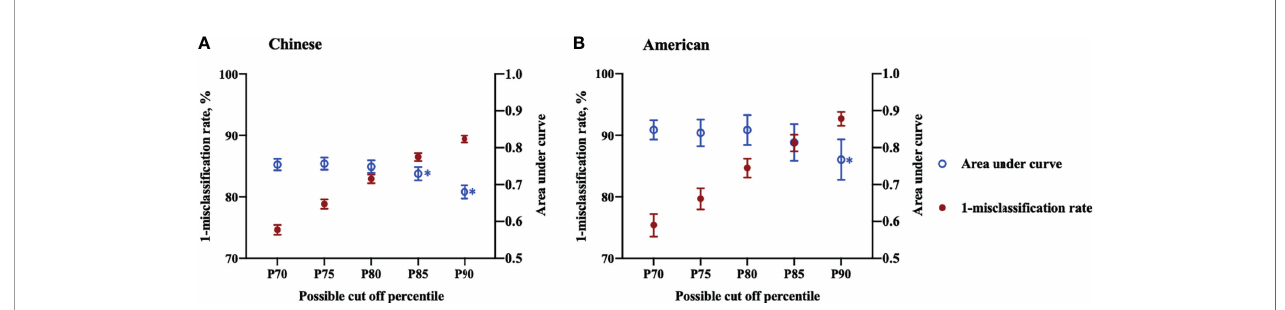
FIGURE 2 | Misclassi fi cation rates and area under curves of Tri-ponderal mass index in assessing metabolic syndrome in Chinese and American children. Sex speci fi c P 70 , P 75 , P 80 , P 85 and P 90 were used as threshold values for each population.* The area under curve decreased signi fi cantly compared to the former cut off percentile. (A) Chinese children; (B) American children.